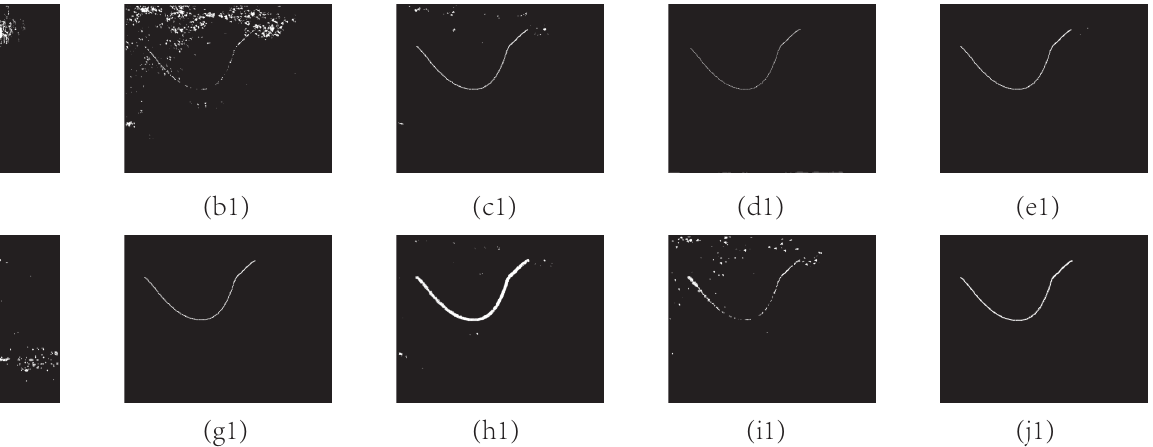
Figure 17. Panels ( a1 – j1 ) shows the detection results of sequence F of top hat, ANI, PSTNN, ASTTV, GST, NTFRA, NRAM, HB-MLCM, ADMD, and the proposed